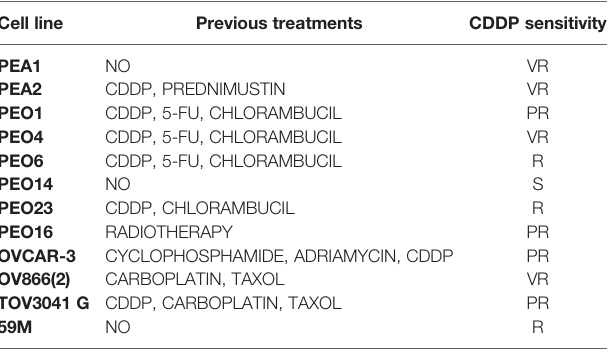
TABLE 1 | Cell line characteristics. Previous treatments received by the patients and CDDP sensitivity group based on our previous report (17). Cell